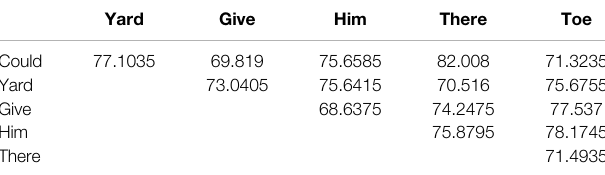
TABLE 6 | Average pairwise classi fi cation accuracy of selected words for subject